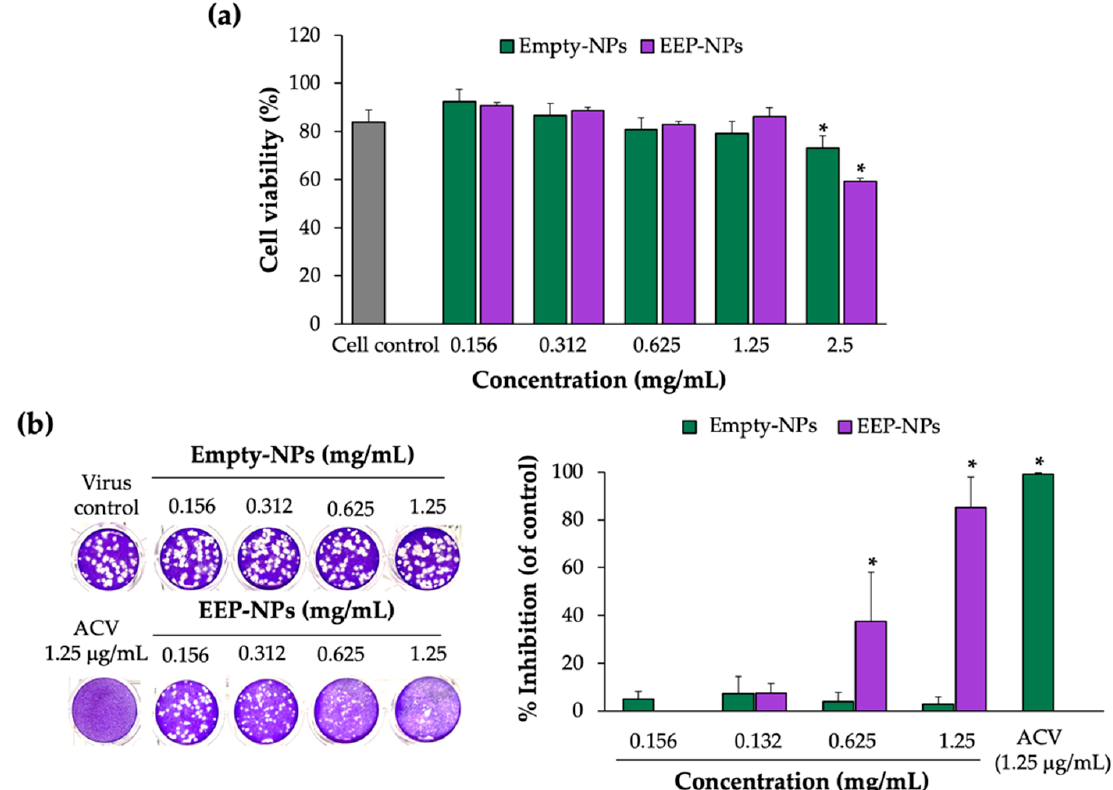
Figure 3. Cytotoxicity and anti-HSV-2 activity of the EEP-NPs. ( a ) Determination of cytotoxicity of the NPs on the Vero cells. The cells were treated with various concentrations of the EEP-NPs (or the Empty-NPs), and cell viability was evaluated by means of the trypan blue exclusion assay. ( b ) Dose–response effect of the EEP-NPs against HSV-2. The HSV-2-infected cells were treated with different concentrations of the EEP-NPs, Empty-NPs, or ACV at IC 90 (1.25 µ g/mL). The antiviral activity was determined by means of the plaque reduction assay. The results represent the means ± SEM from three independent experiments performed in triplicate. Note: * p < 0.05—significant compared to the virus control. Table 2. Cytotoxicity concentrations (CC), inhibition concentrations (IC), and selectivity index (SI) of the NPs.